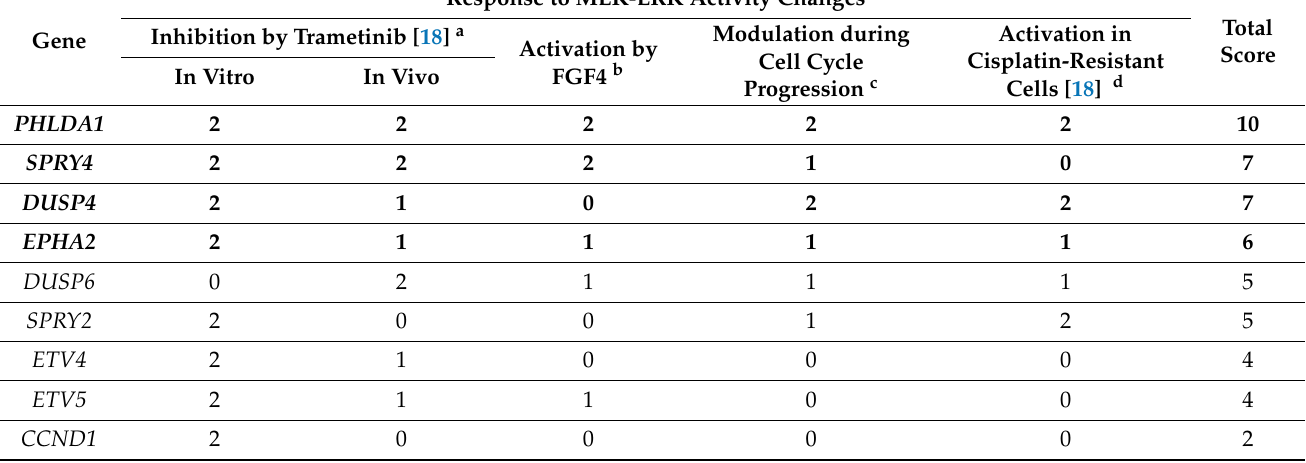
Table 1. Summary of MPAS genes’ response to MEK-ERK pathway activity changes across all analyzed experimental models (including data reported in [18], see also Figure S4). Genes emphasized with bold text display the highest potential for their use as MEK/ERK pathway